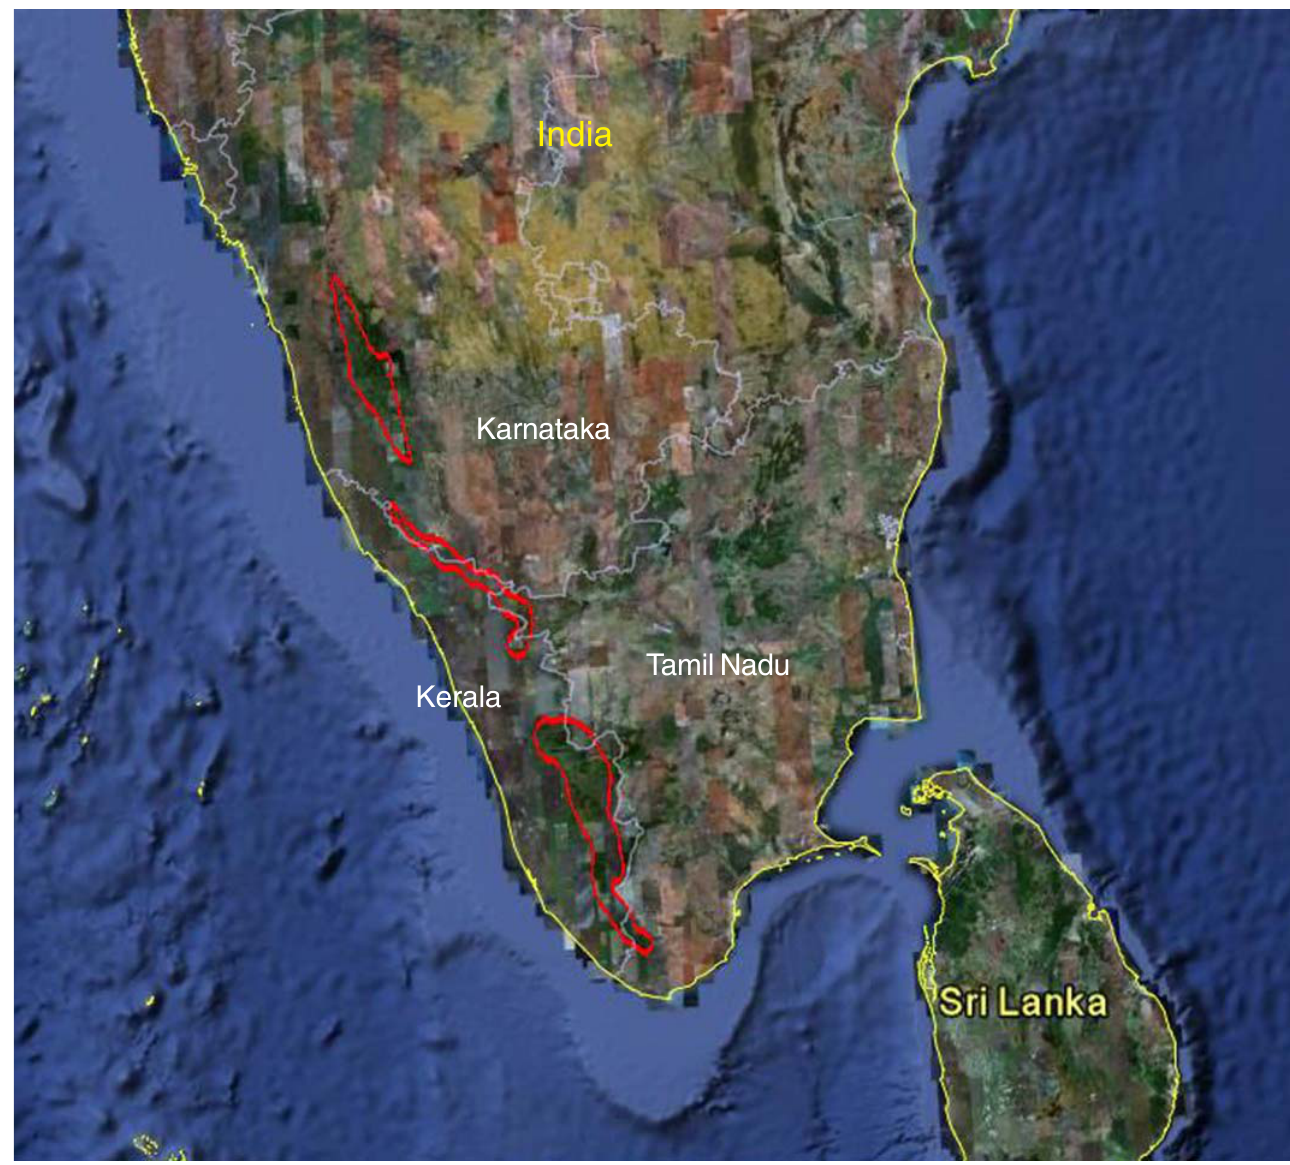
polygons is due to the Palghat gap dividing the Annamalai hills fragments from Silent Valley National Park subpopulation. The break between the middle and northern polygons is in Coorg district of Karnataka where LTM does not occur due to hunting although the habitat is suitable. Map created using Google